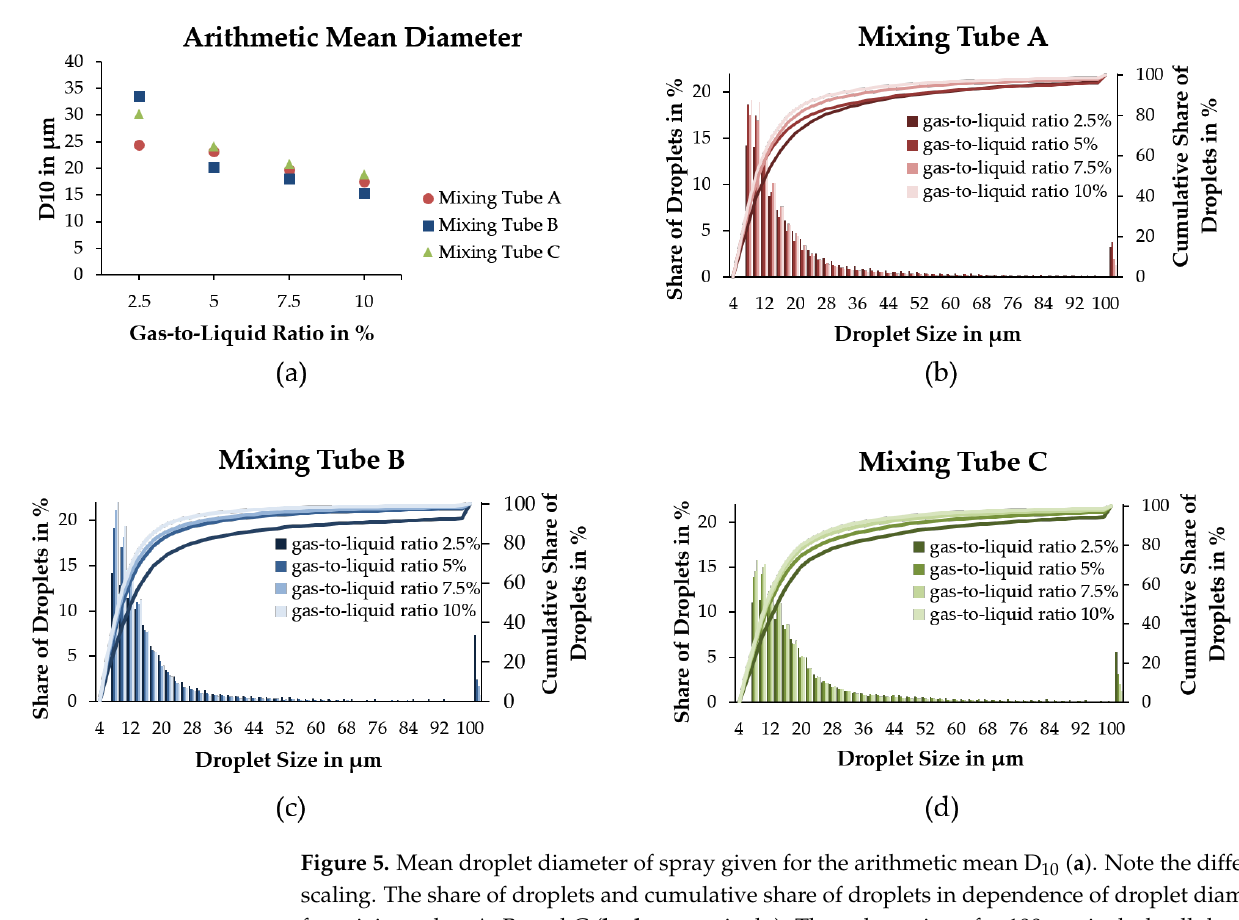
Figure 5. Mean droplet diameter of spray given for the arithmetic mean D 10 ( a ). Note the different scaling. The share of droplets and cumulative share of droplets in dependence of droplet diameter for mixing tubes A, B, and C ( b – d , respectively). The values given for 100 µm include all droplets between 100 to 500 µm.